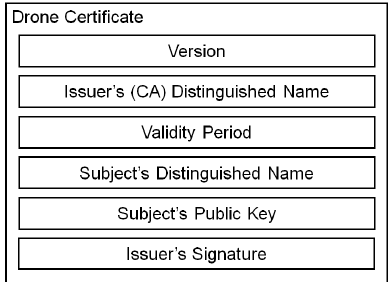
Figure 7. Structure of the proposed certificate format for